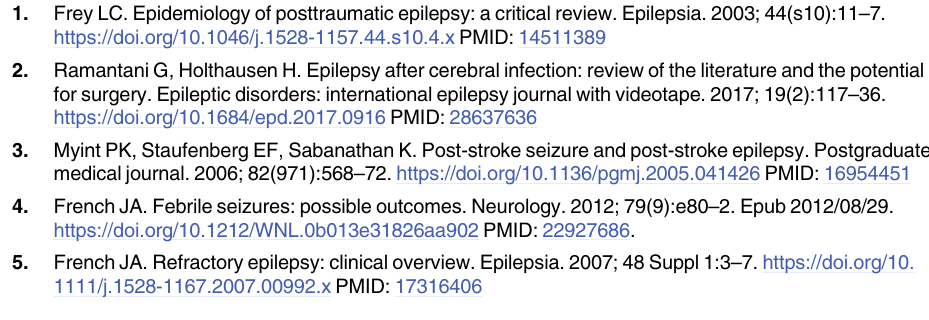
S1 Table. Wnt pathway transcriptional data. Transcriptional data of Wnt genes 3 days after seizure induction, demonstrating fold-change in gene expression in seizure group compared to